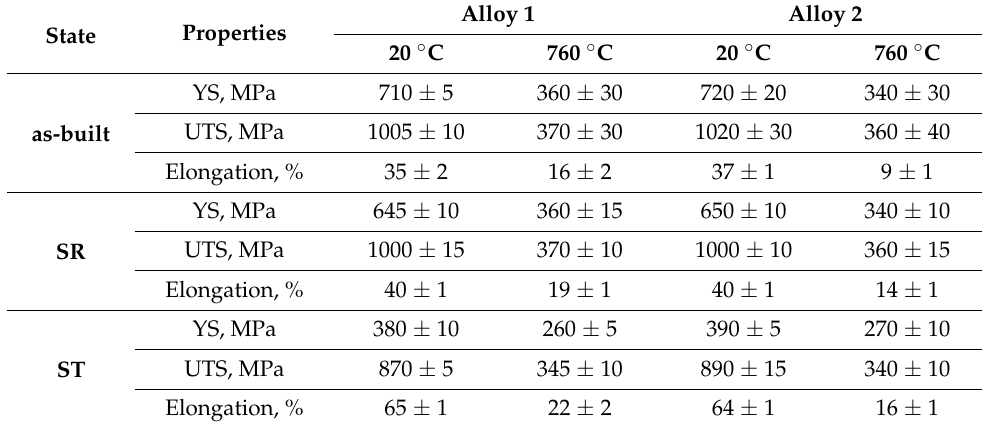
Table 2. Mechanical properties of the LPBF IN625